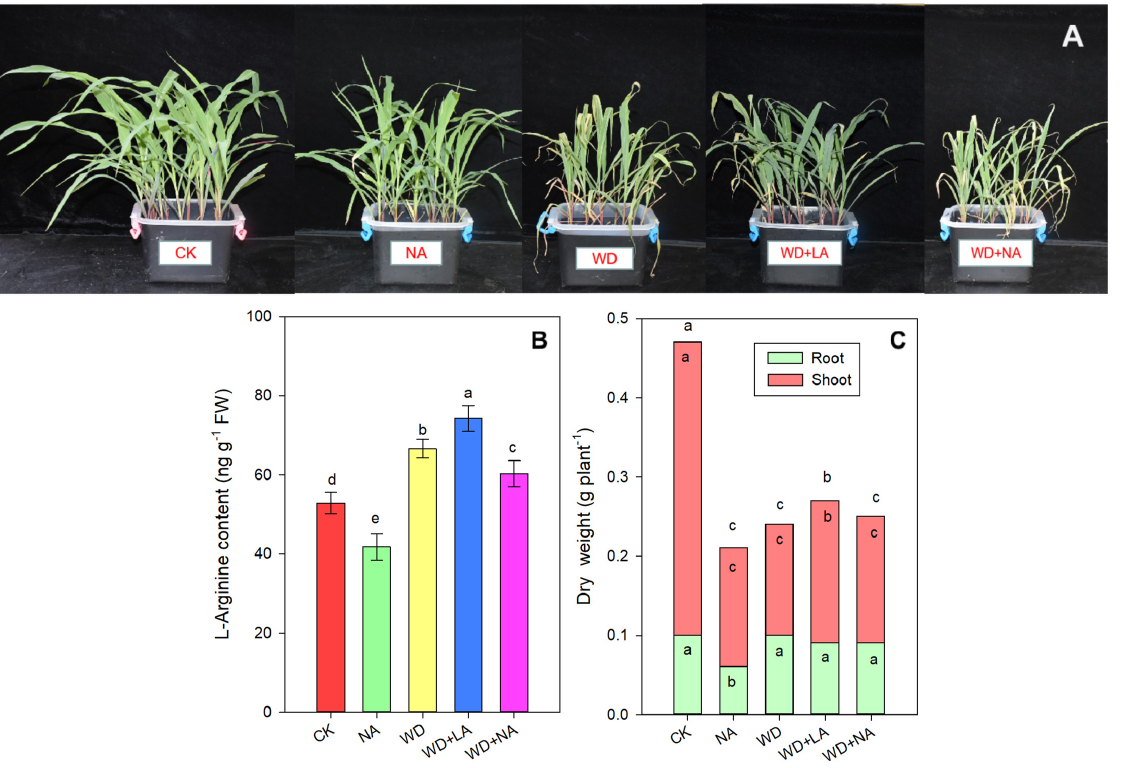
Figure 1. Enhanced growth of maize seedlings induced by supplementation with exogenous L-arginine under drought stress ( A ). Dry weight ( B ) and L-arginine content ( C ) of the maize seedlings under different treatments. CK: control treatment; NA: 25 μ mol L − 1 of L-NAME; WD: 20% PEG; WD + LA: 20% PEG + 150 μ mol L − 1 of L-arginine; WD + NA: 20% PEG + 25 μ mol L − 1 of L-NAME. The results are presented as the means ± standard error (n = 3). Significant differences are represented by lowercase letters ( p ≤ 0.05) based on the LSD test. Different lowercase letters on the top of the columns in ( B ) indicate significant differences in the biomass of the whole plant ( p < 0.05). The different lowercase letters in the columns with the same colors in C indicate significant differences within each treatment ( p < 0.05), while those above the error bars indicate significant differences among the five treatments ( p < 0.05). L-NAME, N γ -nitro-L-arginine methyl ester; LSD, least significance difference; PEG, polyethylene glycol.